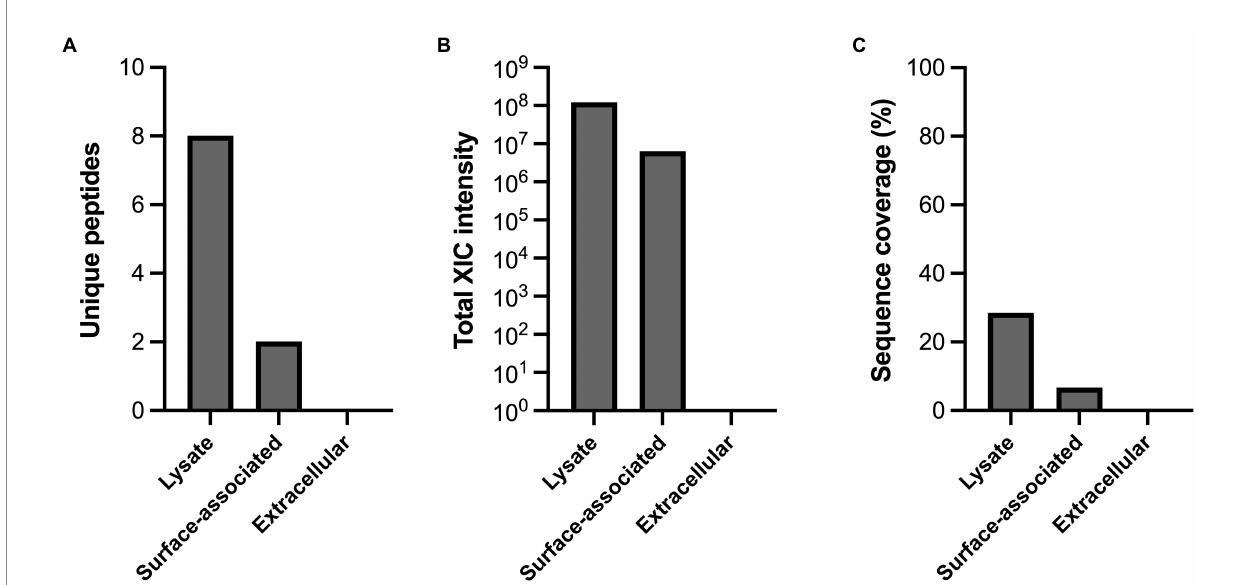
FIGURE 7 Cellular localization of MdpL in Limosilactobacillus fermentum . (A) The quantity found in either lysate, surface-associated or extracellular samples of L. fermentum is calculated and based on the identified unique MdpL-derived peptides, (B) the total extracted ion current (XIC) intensity from MdpL peptides (C) and the total sequence coverage of all MdpL